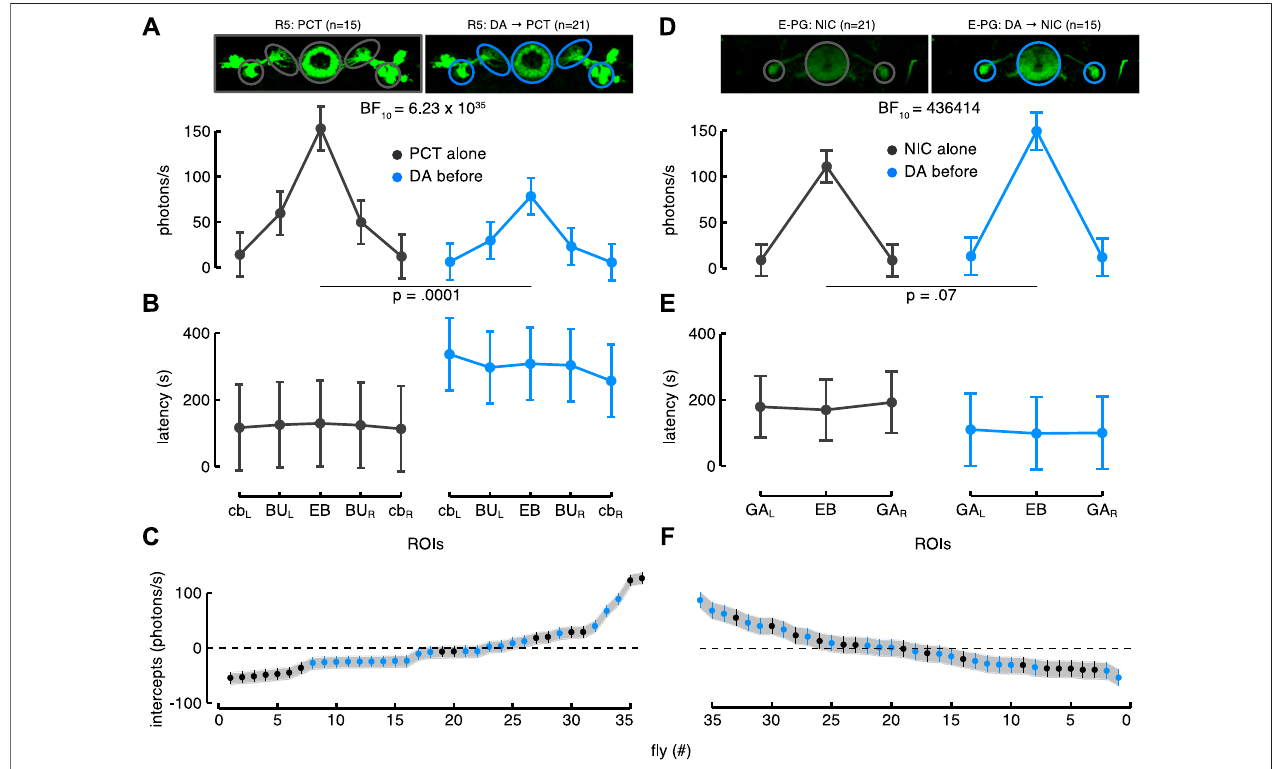
FIGURE 6 | Dopamine modulation of R5 > G5A (A – C) and E-PG > G5A fl ies (D – F) . (A) Estimated parameters of the Ca 2+ -response referred to the interaction betweencondition andROIs(i.e., fi xed effect)withcorrespondingCI(computed asin Figure5C ).Ontheleft isrepresentedtheCa 2+ -response topicrotoxin(PCT) alone inthe fi veROIsoftheR5neurons(back, n =15),whileontherightisrepresentedtheirCa 2+ -responsetopicrotoxinafterdopamine(DA)application(blue, n =21)(seealso Supplementary Movie S5 for a representative brain response). (B) Estimated parameters of the response latency referred to the interaction between condition and ROIs (computed as in Figure 5D ). On the left is represented the latency response to picrotoxin alone in the fi ve ROIs of the R5 neurons (black) while on the right is represented their latency response to picrotoxin after dopamine application (blue). (C) Plot of random effect referred to Ca 2+ -response of R5 neurons (as in Figure 5E ). (D) EstimatedparametersoftheCa 2+ -responsereferredtotheinteractionbetweenconditionandROIs(asin Figure5C ).OntheleftisrepresentedtheCa 2+ -responseto nicotine(NIC)aloneinthethreeROIsoftheE-PGneurons(black, n =21),whileontherightisrepresentedtheirCa 2+ -responsetonicotineafterdopamine(DA)application (blue, n = 15) (see also Supplementary Movie S6 for a representative brain response). (E) Estimated parameters of the response latency referred to the interaction between condition and ROIs(computed as in Figure 5D ). On the left is represented the latency response tonicotine alonein the three ROIs ofthe E-PG neurons (black) while on the right is represented their latency response to picrotoxin after dopamine application (blue). (F) Plot of random effect referred to Ca 2+ -response of E-PG neurons (as in Figure 5E